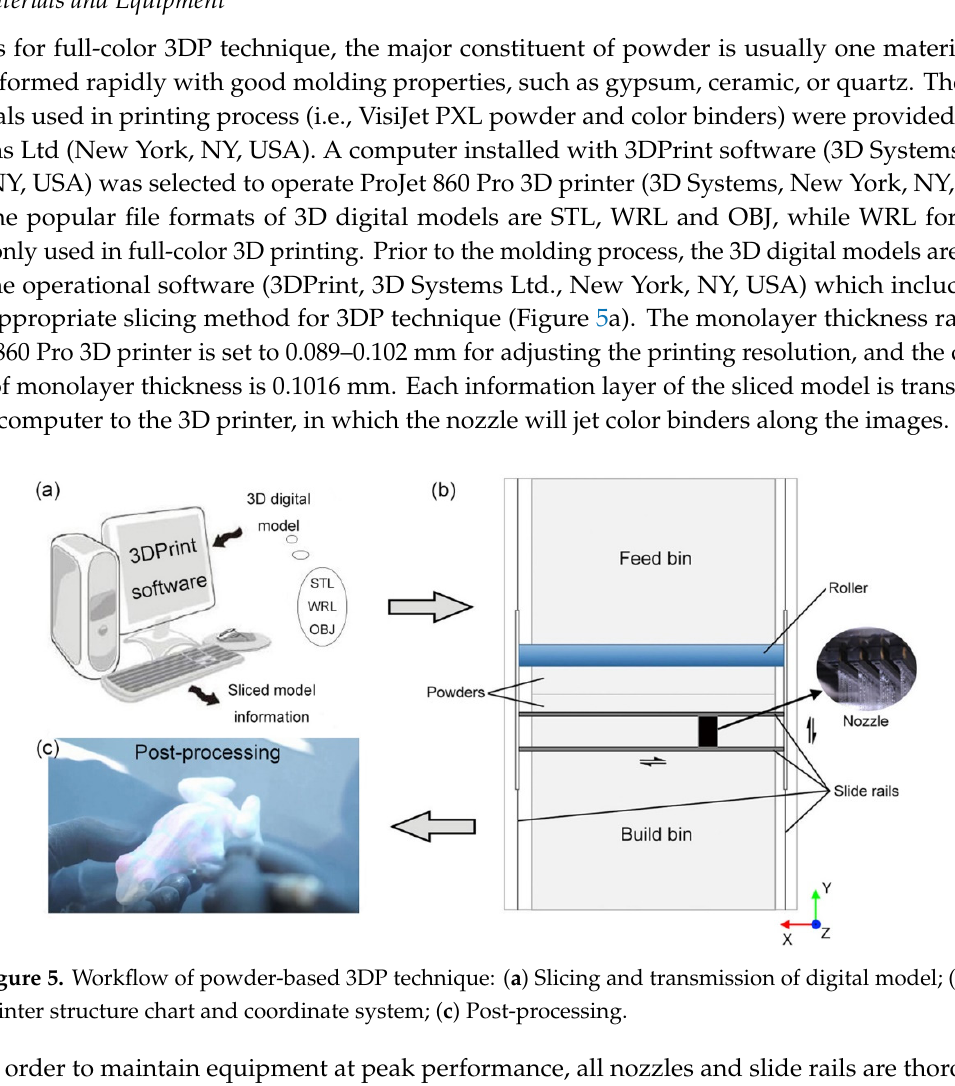
Table 3. Parameter values related to seamless adhesion of four adhesives.